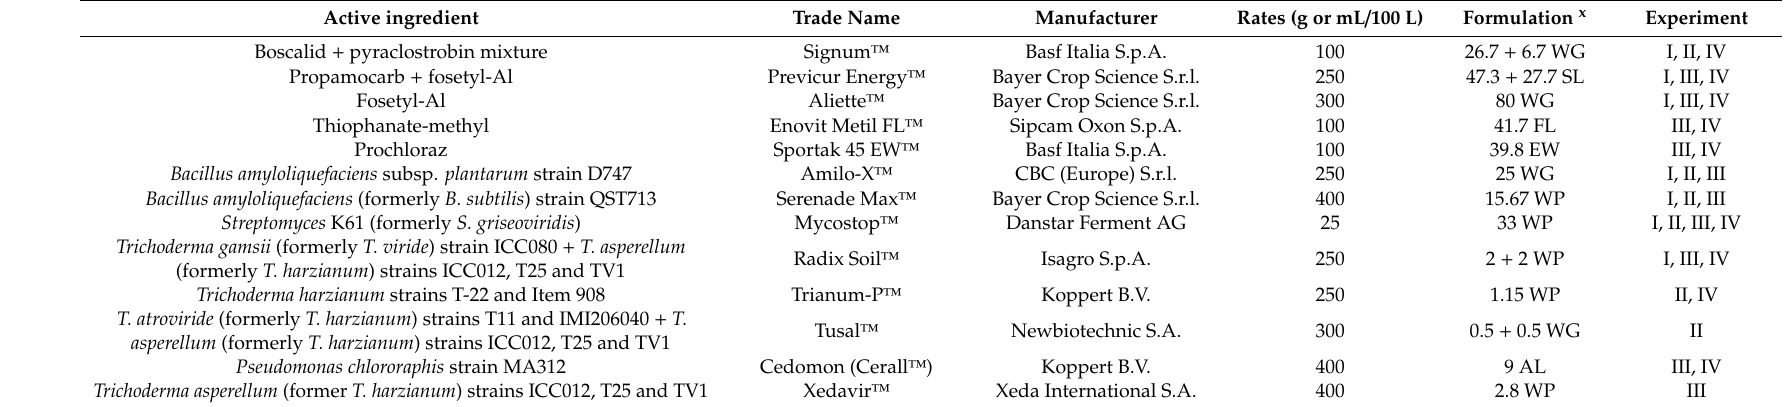
Table 5. Fungicides and biological control agents selected in the